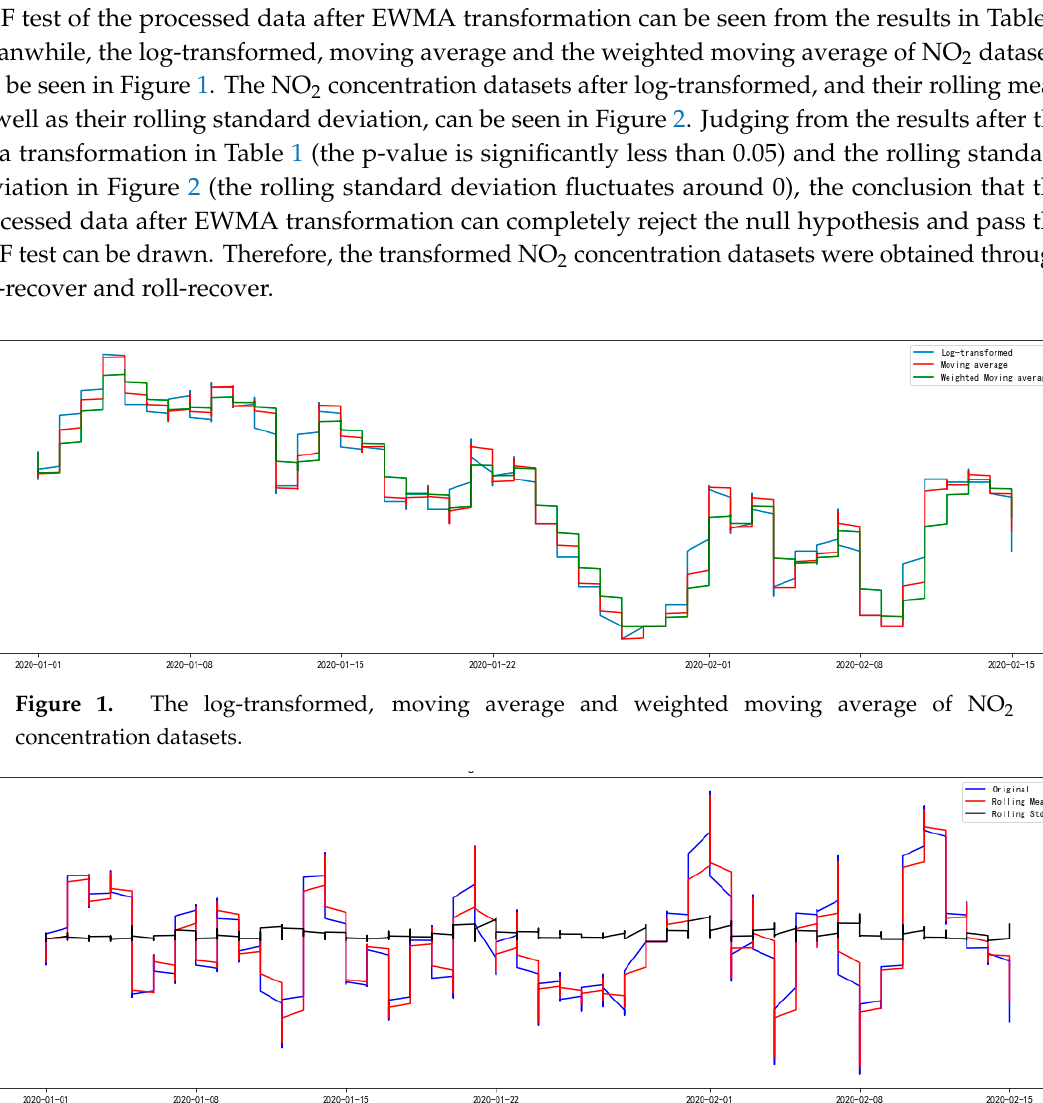
Table 1. Results of augmented Dickey–Fuller (ADF) test before and after the data transformation of NO 2.